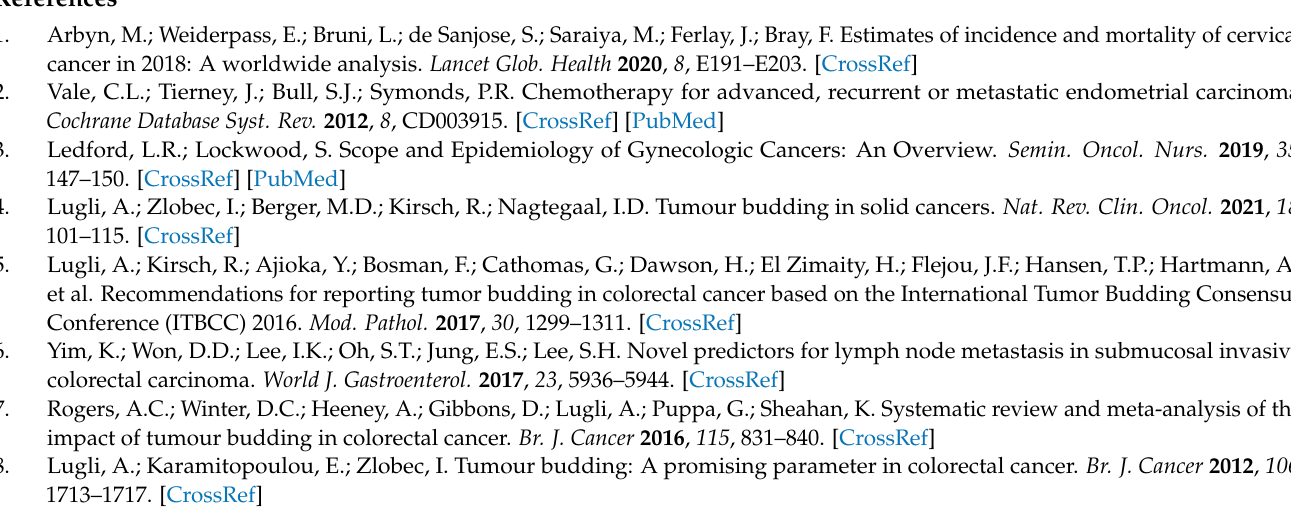
Figure S2: Subgroup analysis of tumor budding according to the univariate vs. multivariate analysis in gynecological cancer patients; overall survival (a) disease-free survival (b); Figure S3: Subgroup analysis of tumor budding according to ethnicity in gynecological cancer patients; overall survival (a) disease-free survival (b); Figure S4: Subgroup hazard ratio analysis of tumor budding and pathological parameters in gynecological cancer patients by (a) age (b) stage (c) depth of invasion (d) N stage (e) M stage (f) tumor grade (g) lymphovascular invasion (h) perineural invasion,; Table S1: Detailed overview of keywords used for search strategy; Table S2: Main characteristics of all included gynecological cancer studies; Table S3: Characteristics of patients’ clinicopathological data included in the